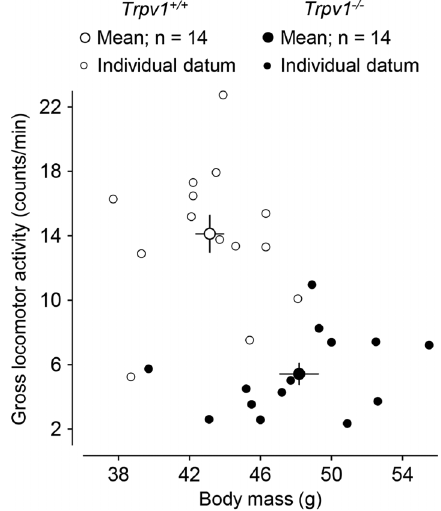
Figure 1. Transient receptor potential vanilloid type 1 (TRPV1) channel modulates spontaneous locomotor activity. The fi gure shows that aged Trpv1 -knockout mice have a higher body mass and lower spontaneous locomotor activity than their genetically unaltered littermates. The fi gure was modi fi ed from Wanner et al.